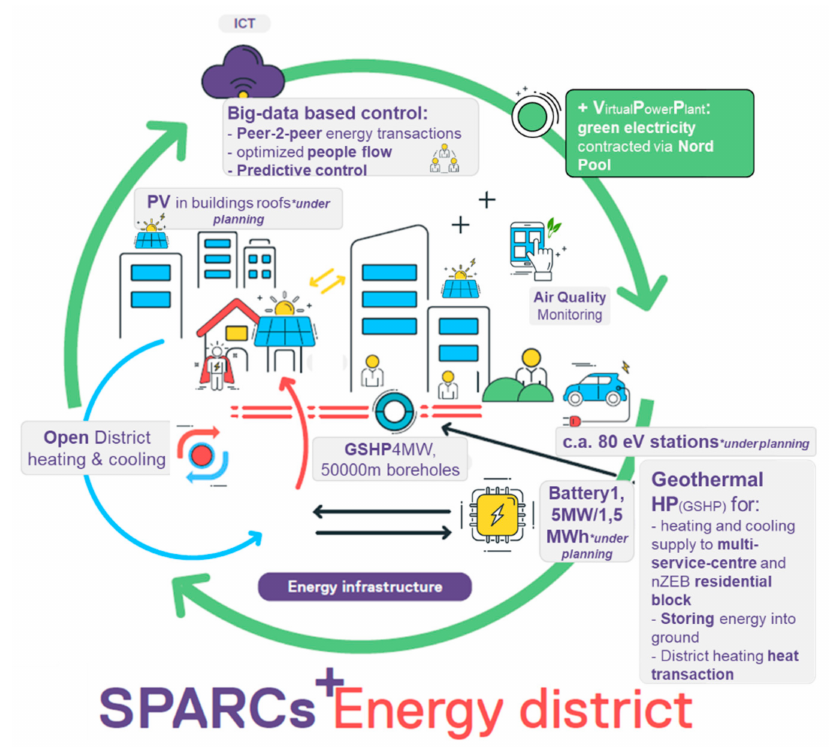
Figure 8. Diagram for the urban Lippulaiva Lab provided by VTT (Finland).